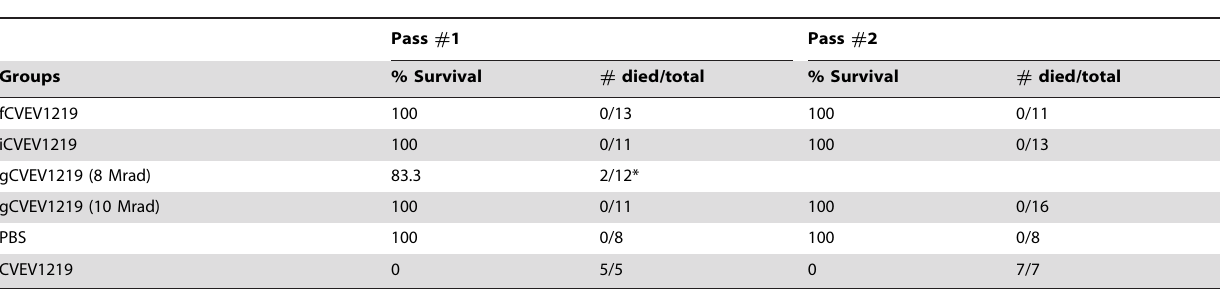
Table 4. In Vivo Inactivation Evaluation in Suckling